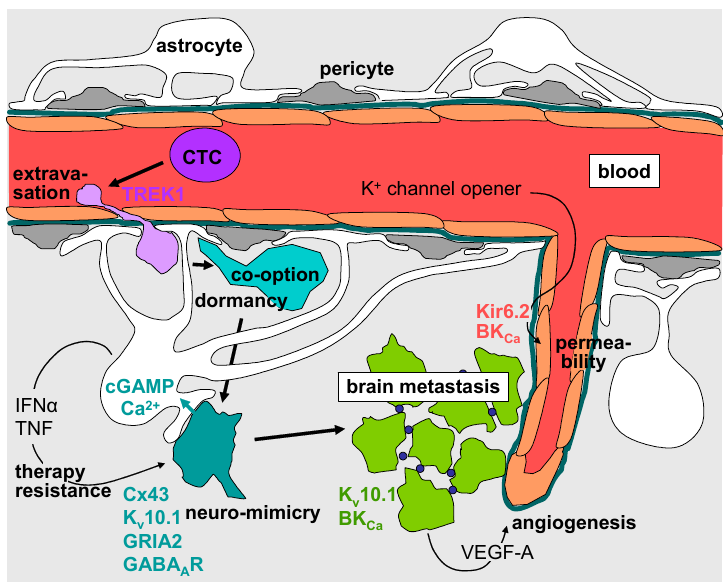
Figure 2. Synopsis of ion channel types involved in extravasation of cancer cells in the brain, neuromimicry, and modulation of the permeability of the brain blood cancer barrier. CTC: circulating cancer cells; VEGF-A: vascular endothelial growth factor A; IFN α : interferon- α ; TNF: tumor necrosis factor. Arrows define the sequence of processes leading to the establishment of brain metastases.